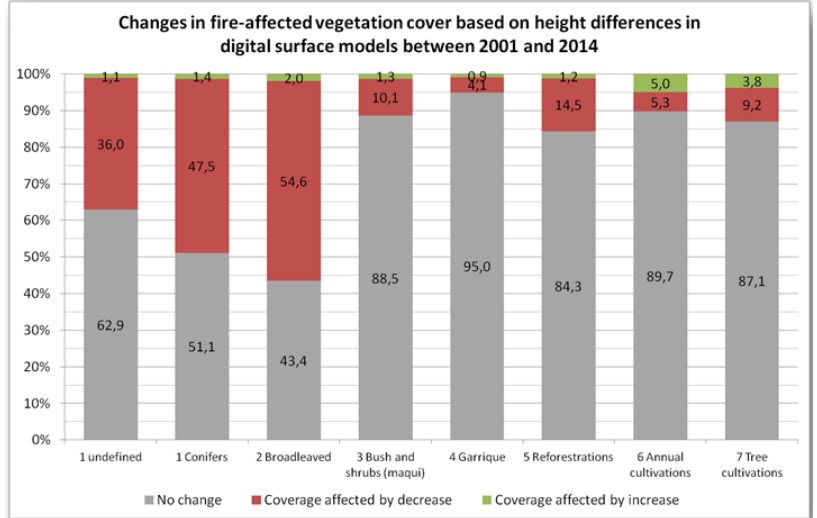
Figure 11. Change in fire-affected vegetation